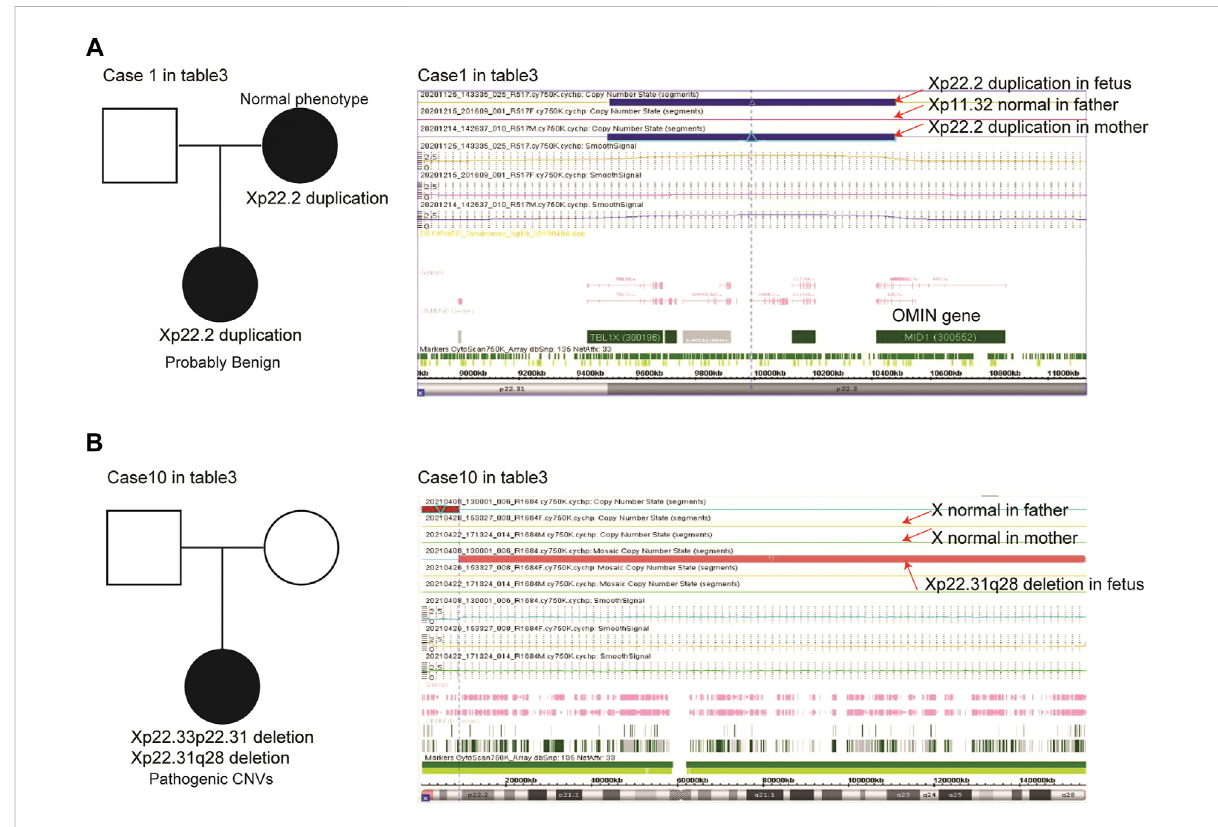
FIGURE 2 Parent-of-origins of the X chromosomal deletions/duplications in case 1 (A) and case 10 (B) female